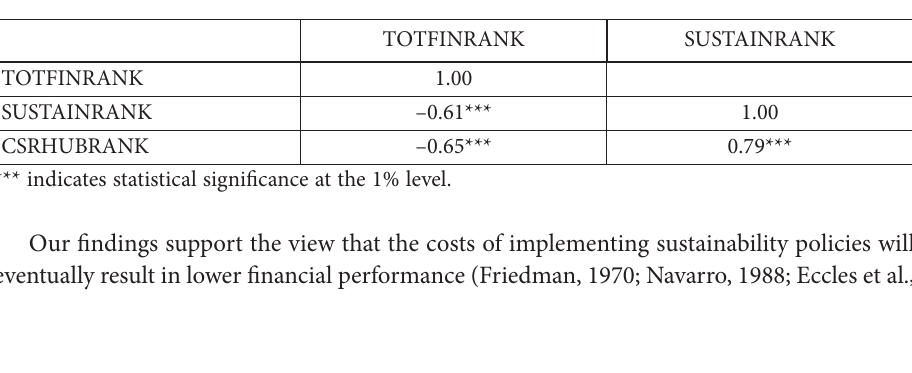
Table 4. Pearson correlation coefficients for the rankings of